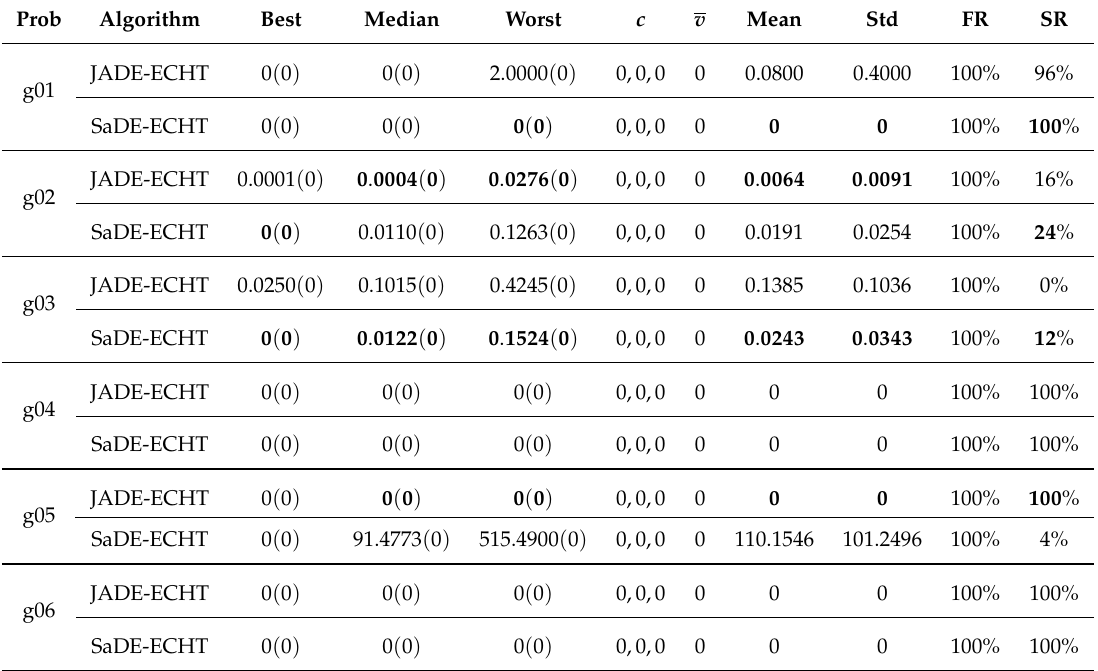
Comparison of self-adaptive differential evolution with optional external archive (JADE)-ensemble of constraint handling techniques (ECHT) and self-adaptive differential